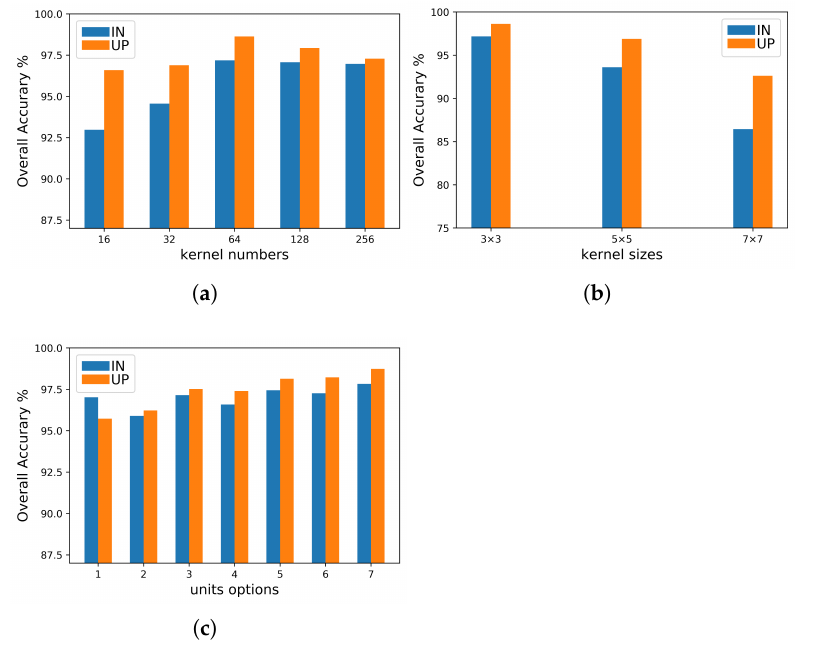
Figure 10. Overall accuracies of AWF 2 -Add.-GAN with various kernel settings and number of neurons in their spectral and spatial feature extractors, sampled on two datasets for training. ( a ) Effect of the number of kernels, ( b ) kernel sizes, and ( c ) number of neurons for spectral purity analysis.